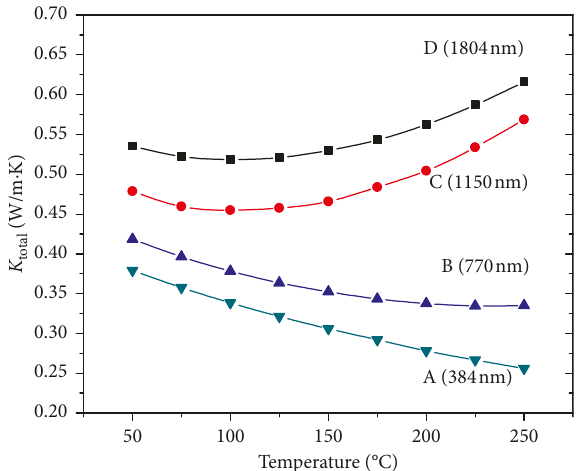
Figure 8: Calculation of total thermal conductivity for Sb films as a function of measuring temperature.